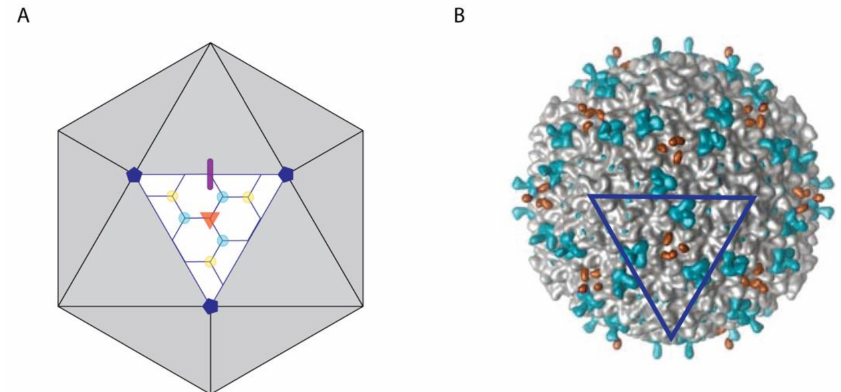
Figure 1. Symmetry of capsid-binding sites for decoration proteins. ( A ) Model of a T = 7 icosahedral capsid with symmetry sites highlighted on one facet. The 2-, 3-, and 5-fold symmetry axes are shown by a thick purple line, an orange triangle, and dark blue pentagons, respectively. Additionally, two types of quasi-3-fold axes are indicated. The first connects only hexons and is shown by cyan dots, the second connects two hexons and a penton and is shown using yellow dots. ( B ) Surface map of the phage L capsid bound by the decoration protein Dec (L) at 3-fold (orange) and type I quasi-3-fold (cyan) sites, corresponding to those illustrated in panel A. The dark blue triangle outlines a facet in the same orientation as in panel A. The figure is adapted from Tang et al.